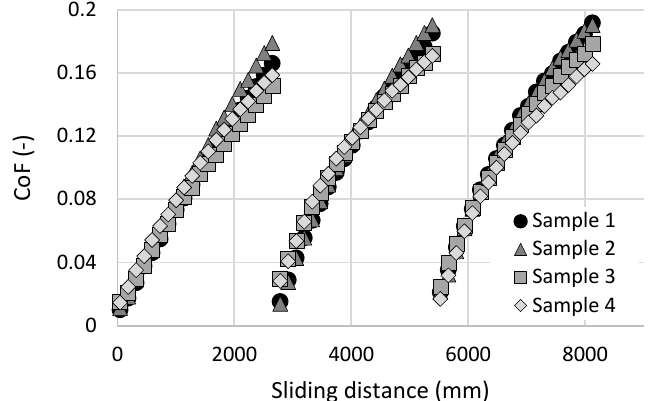
Figure 3. Coefficient of friction as a function of a sliding distance for four cartilage samples lubricated by phosphate buffer saline (PBS).